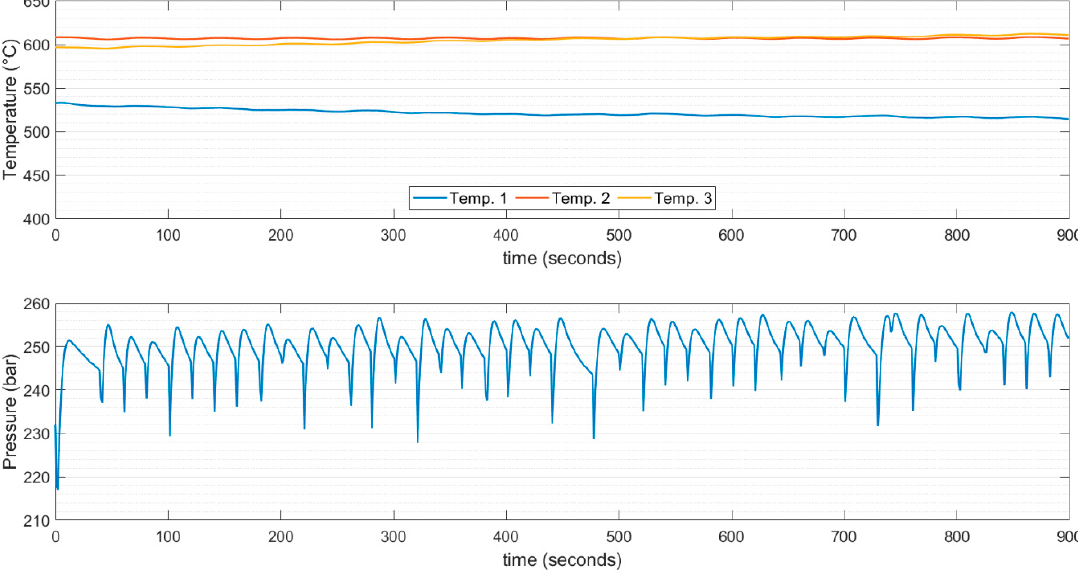
Figure 6. Temperatures and pressure values, recorded for the duration of one experiment at a set point temperature of 610 °C.